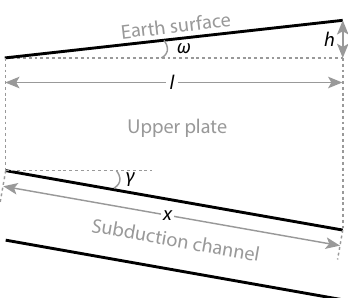
Figure C1. Geometry of topography and subduction